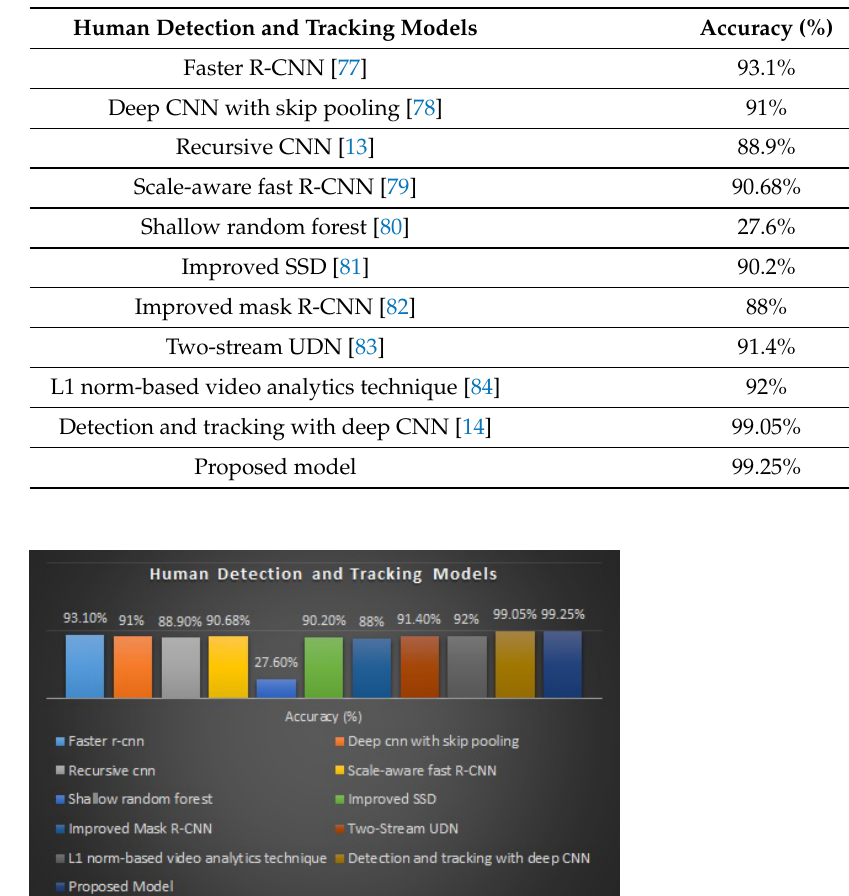
Table 3. Different human detection and tracking models with accuracies.